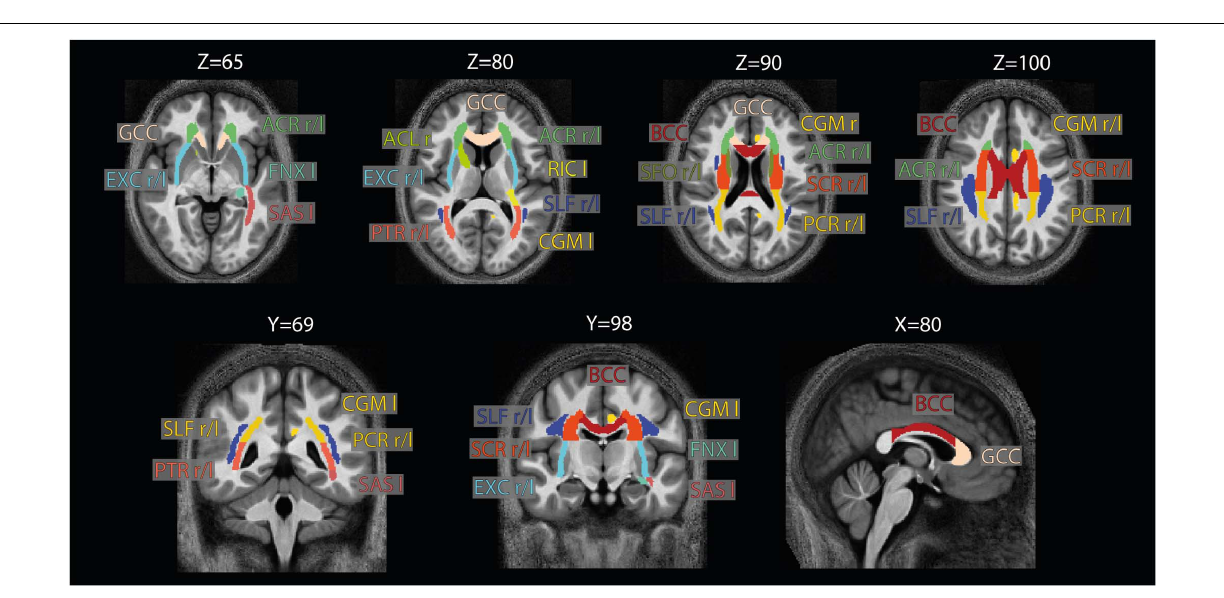
each) using the ACID toolbox, with the values averaged to obtain a single noise estimate. The threshold for SNR maps to create binary SNR map was chosen such that it minimizes the ratio between the number of artifactual voxels where ν icvf ≥ 0 . 999 and the total number of voxels in the SNR mask ( Figure 3B ),